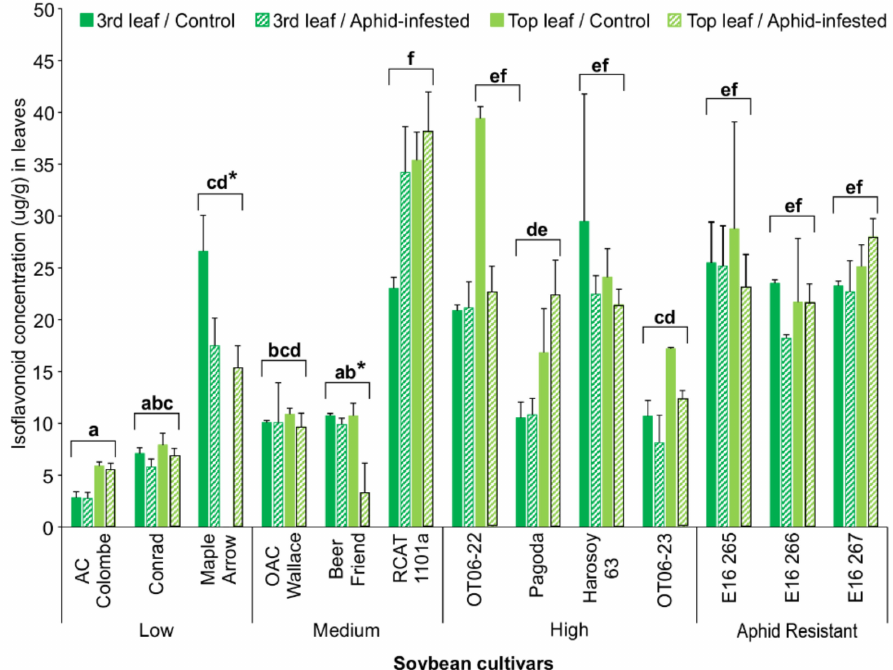
Figure 1. Mean isoflavonoid concentrations ( µ g/g) ( ± S.E.) for 3rd and top full leaves from 13 soybean cultivars at the end of the 10-day bioassay. Low, mid, and high indicate the leaf isoflavonoid levels of the soybean cultivars at the V1 and V3 stages as determined in Scott et al. [20]. Aphid-resistant lines were used as controls. Bars with the same lowercase letters indicate no significant difference ( p > 0.05) for the average isoflavonoid concentrations between those cultivars. Bars with an asterisk (*) indicate a significant difference ( p < 0.05) between the control and aphid-infested leaves for that cultivar.